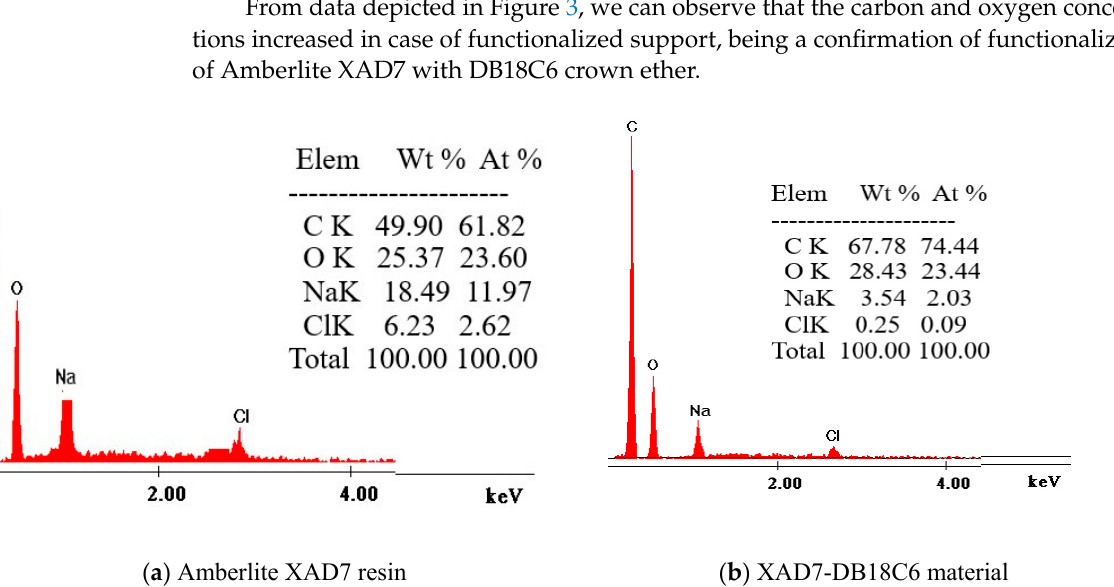
Figure 2. X-ray dispersive energy spectroscopy (EDX) before ( a ) and after functionalization ( b ).